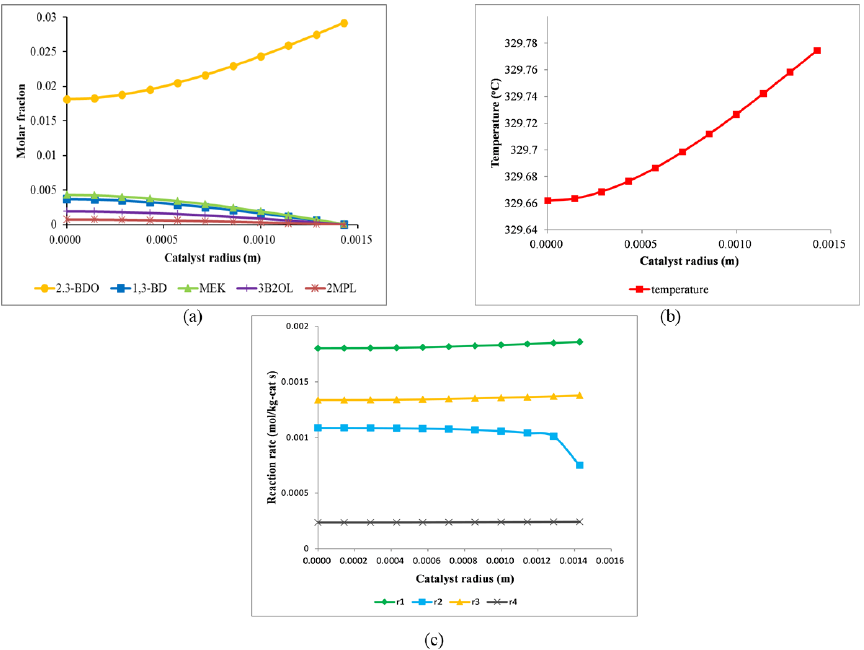
Figure 3. Profiles of the molar fractions of components ( a ), temperature ( b ), and reaction rates ( c ) in the catalyst under the inlet conditions of the